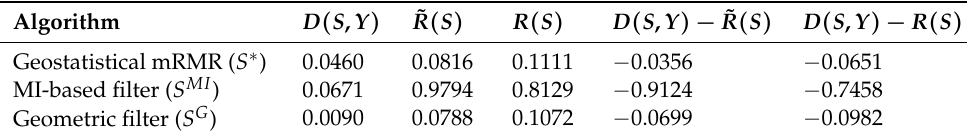
Table 1. Evaluation of the geostatistical mRMR feature selection algorithm.